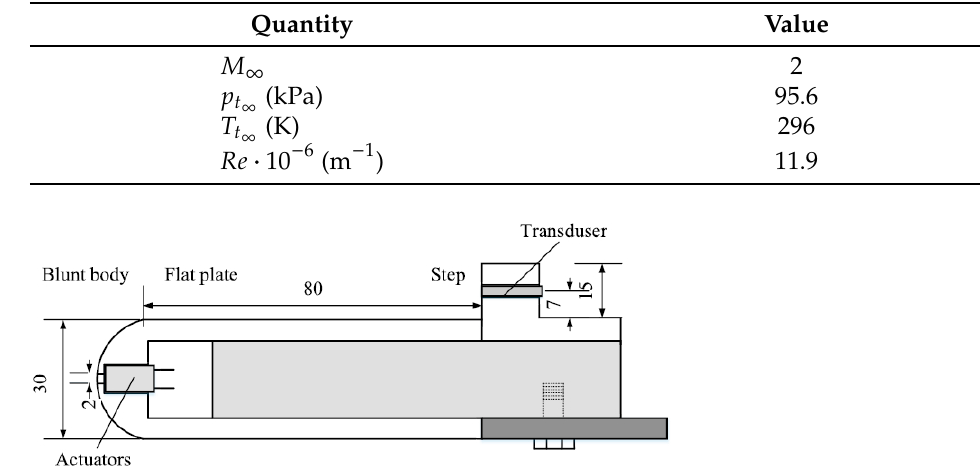
Table 2. Flow Conditions